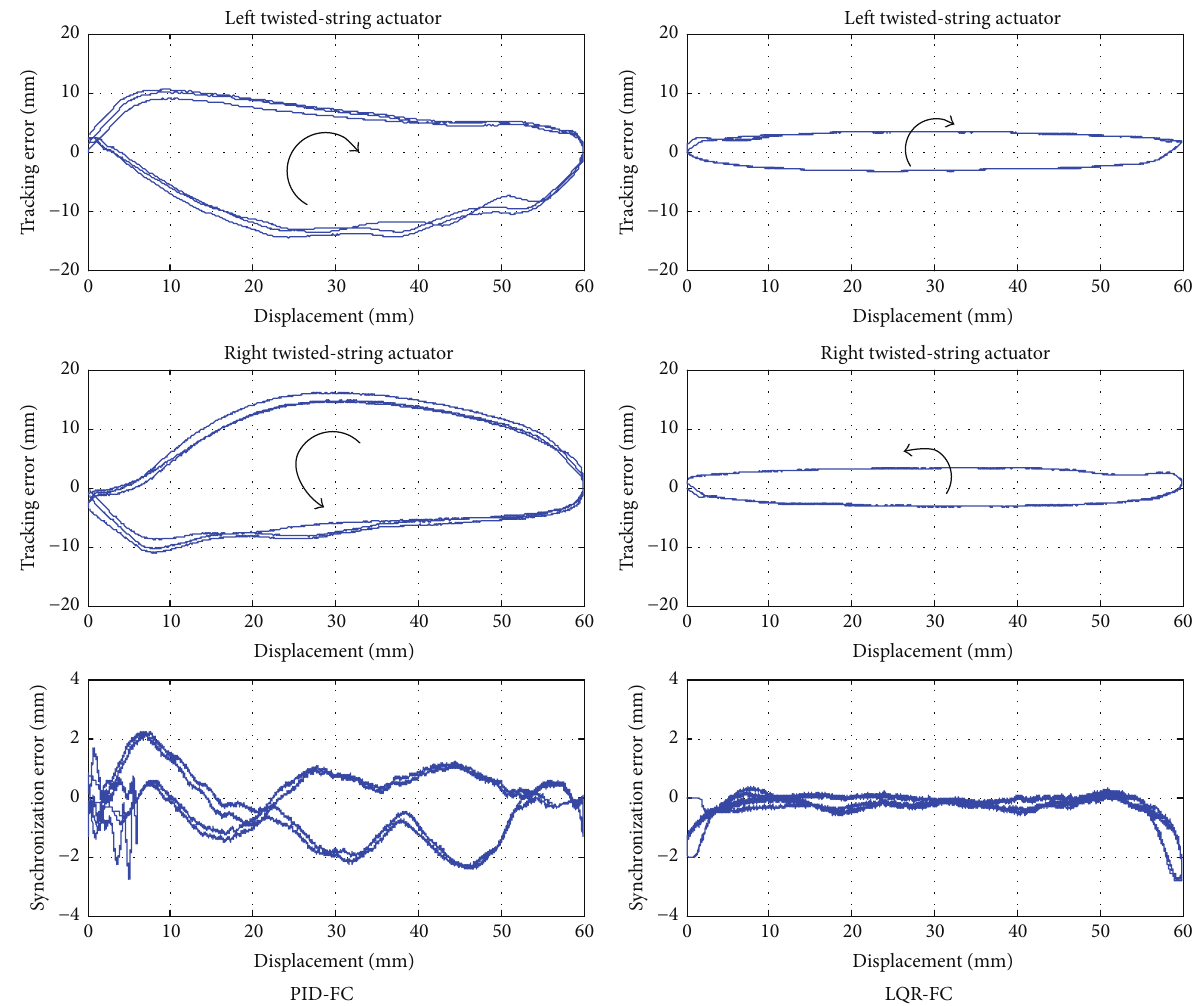
Figure 15: Comparison of tracking and synchronization errors of PID-FC and LQR-FC